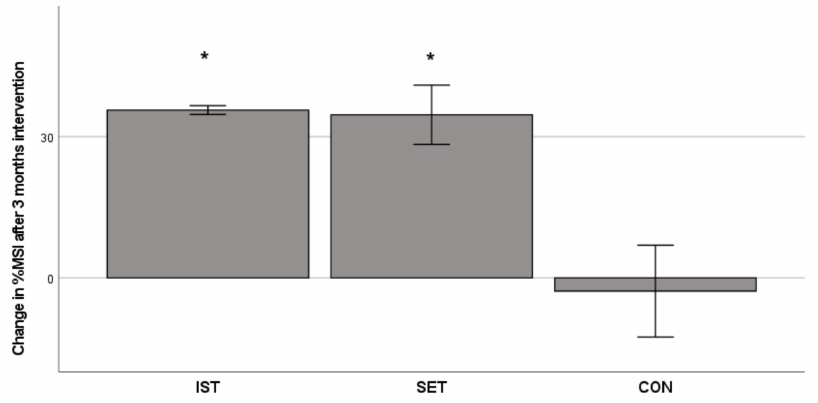
Figure 1. Changes in muscle strength index (MSI, expressed as % change from baseline) after 3 months intervention. Bars represent mean ± SE; * significant change p <